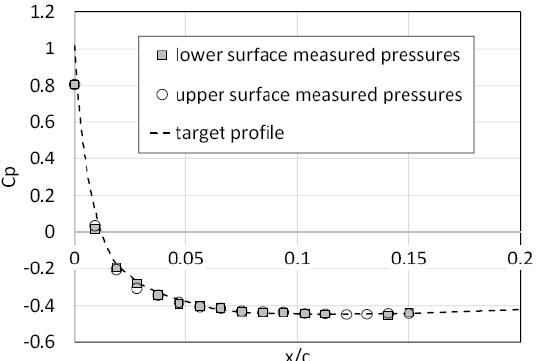
Figure 8. Pressure distribution of the leading − edge matching at AOA = 0°.